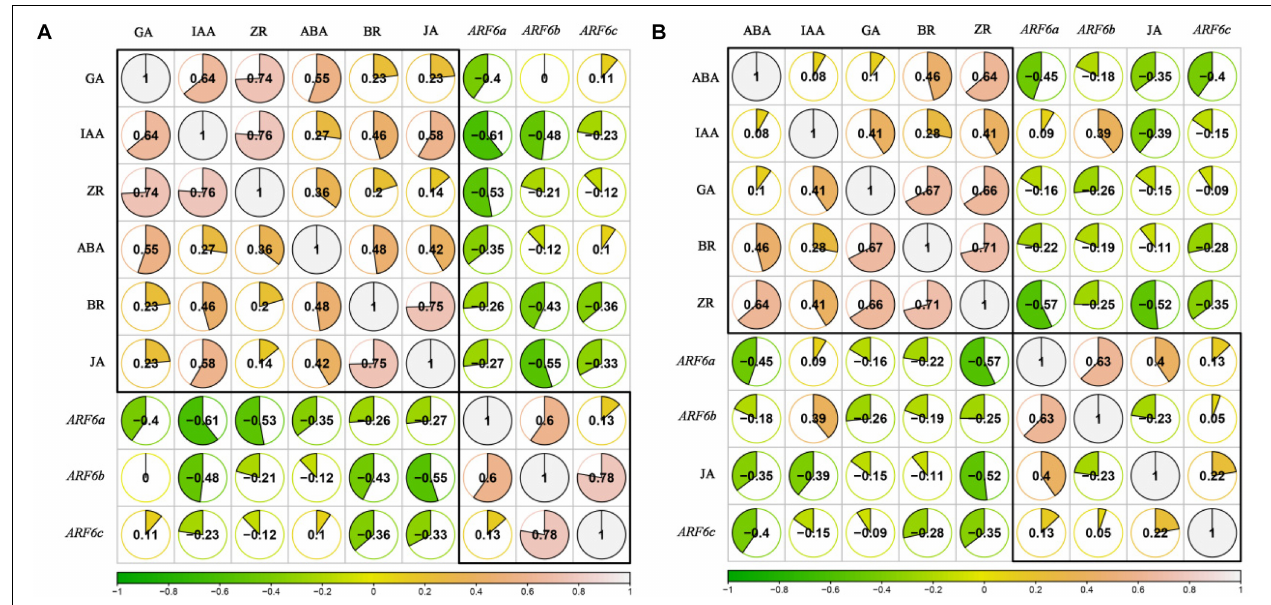
FIGURE 12 | (A) The correlation between endogenous hormones and PgARF6 genes expression after IBA treatment. (B) The correlation between endogenous hormones and PgARF6 genes expression after 6-BA treatment.